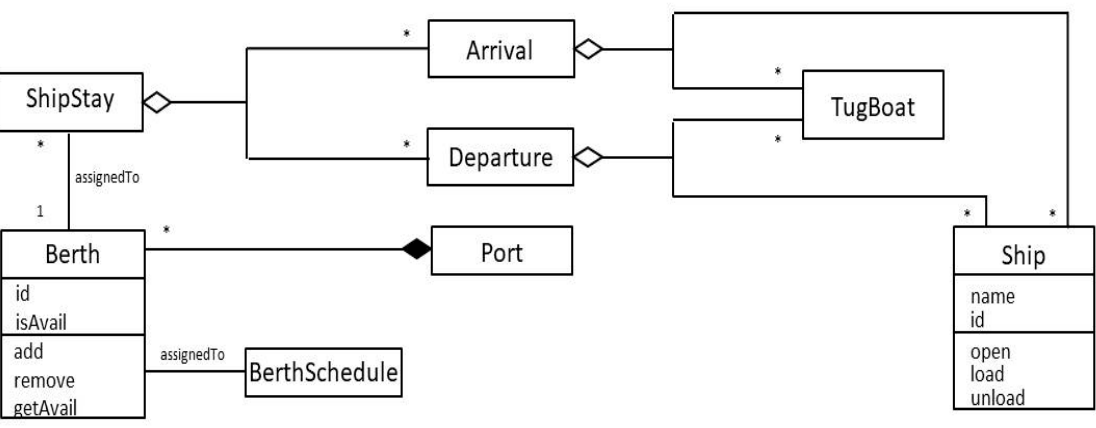
Figure 11. Class diagram of ship arrival and departure operations.